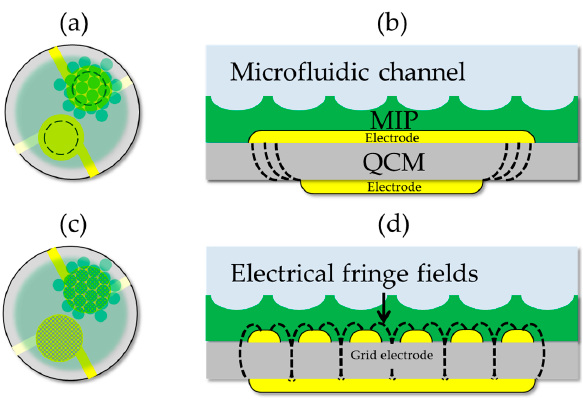
Figure 1. Schematic illustration of the quartz crystal microbalance (QCM) layouts with reference and sensitive electrodes (yellow) covered with a polyurethane thin film (green). The reference electrode is coated with a plane non-imprinted thin film and the sensitive electrode is coated with the surface-imprinted layer. ( a ) Traditional layout with smaller electrodes (broken line) towards the gaseous phase. ( b ) Cross-section of the sensitive layer. With larger electrodes on ground, facing the aqueous phase, the electrical fringe fields (broken lines) are pulled into the crystal. ( c ) QCM layout with a grid electrode facing the aqueous phase. ( d ) Cross-section showing schematic fringe fields at the edges of the grid